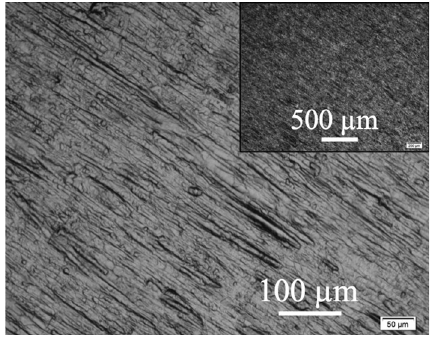
FIG. 8. Optical microscope image of a typical non-EPed coupon surface. Inset: Zoomed-out image of the surface.